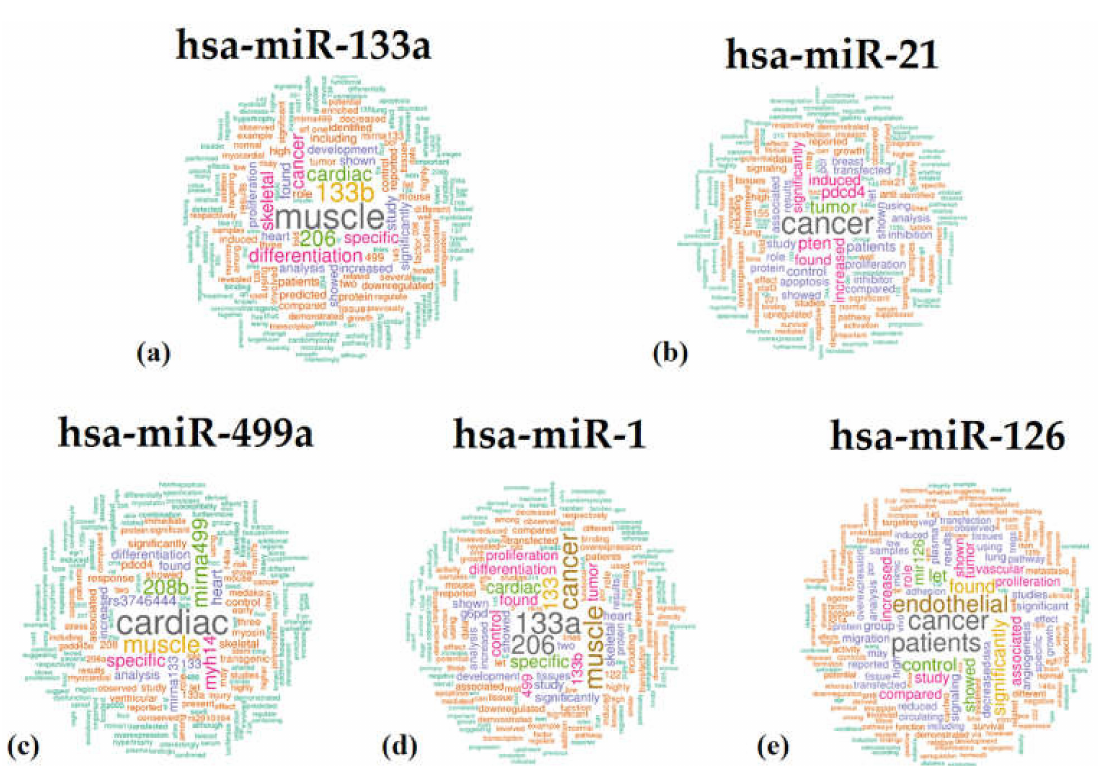
Figure 2. Word cloud for hsa-miR-133a ( a ); hsa-miR-21 ( b ); hsa-miR-499a ( c ); hsa-miR-1 ( d ); hsa-miR- 126 ( e